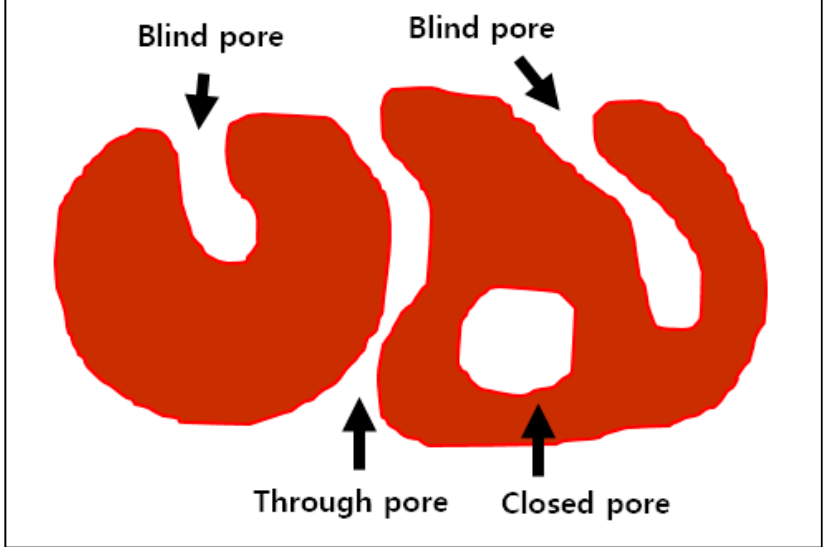
Figure 2. Pore classification by physical shape (Total porosity = Open-pore porosity + Closed-pore porosity; Open-pore porosity = Through-pore porosity + Blind-pore-porosity).